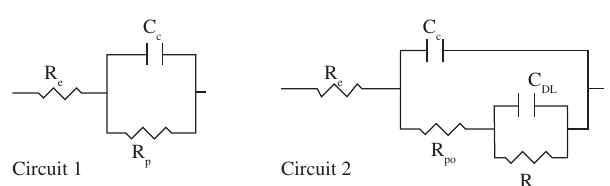
Figure 1. Equivalent electrical circuits utilised to fit EIS data.